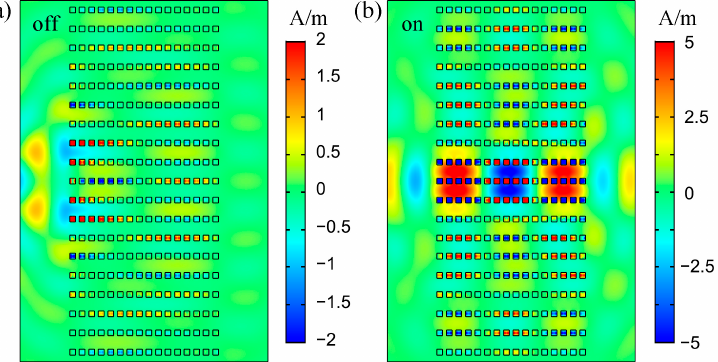
Figure 6. Magnetic field distributions of wave propagating in PHCs at 58.00 THz with pump powers of ( a ) 10 6 V/m (approach linear regime) and ( b ) 3.4 × 10 6 V/m (nonlinear regime).